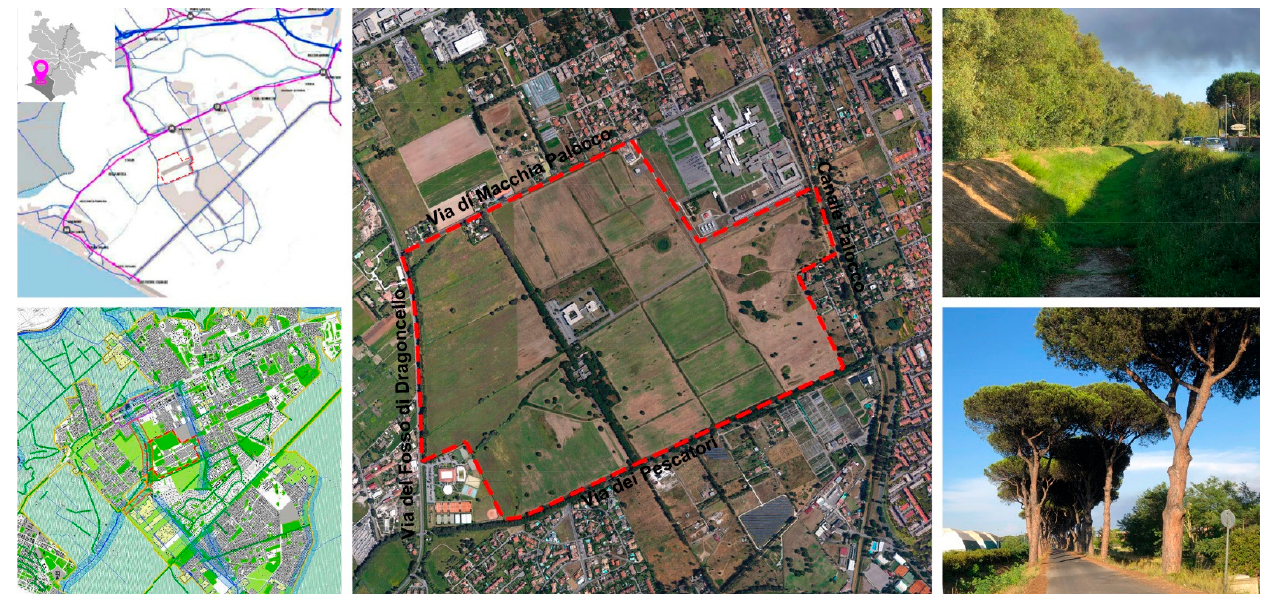
Figure 2. Urban and Metropolitan Centrality “Acilia–Madonnetta”. Top left, D3. Mobility infras-